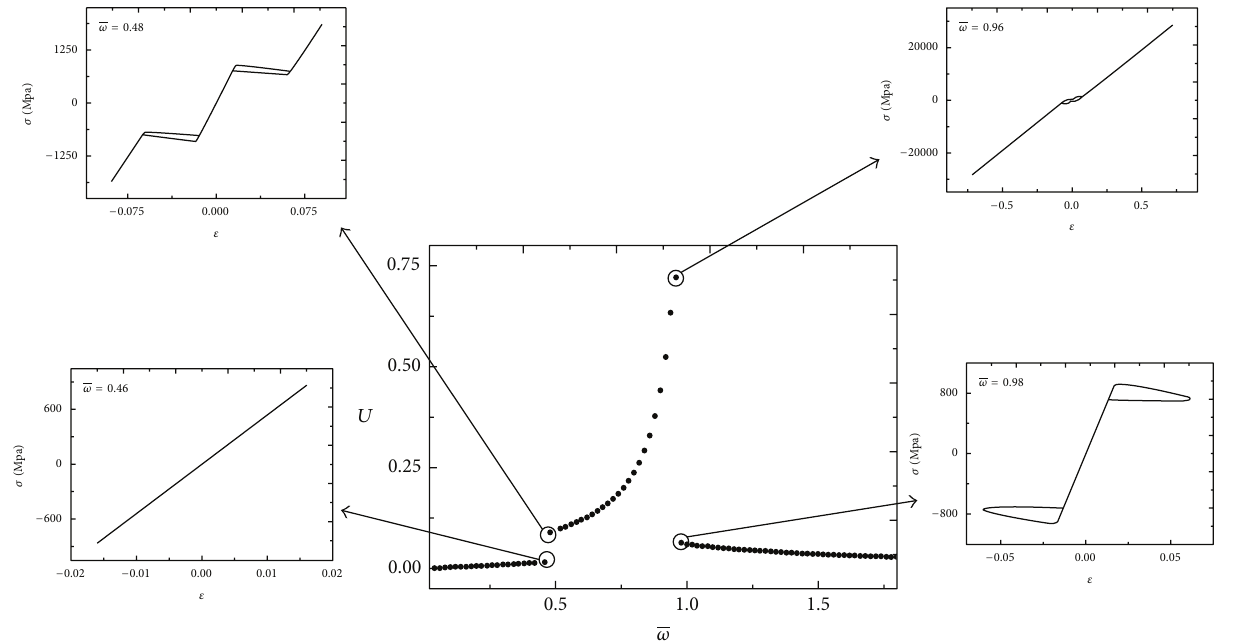
Figure 9: Up-sweep jumps with 𝛿 = 0.012 : comparison between frequency response and stress-strain curves.